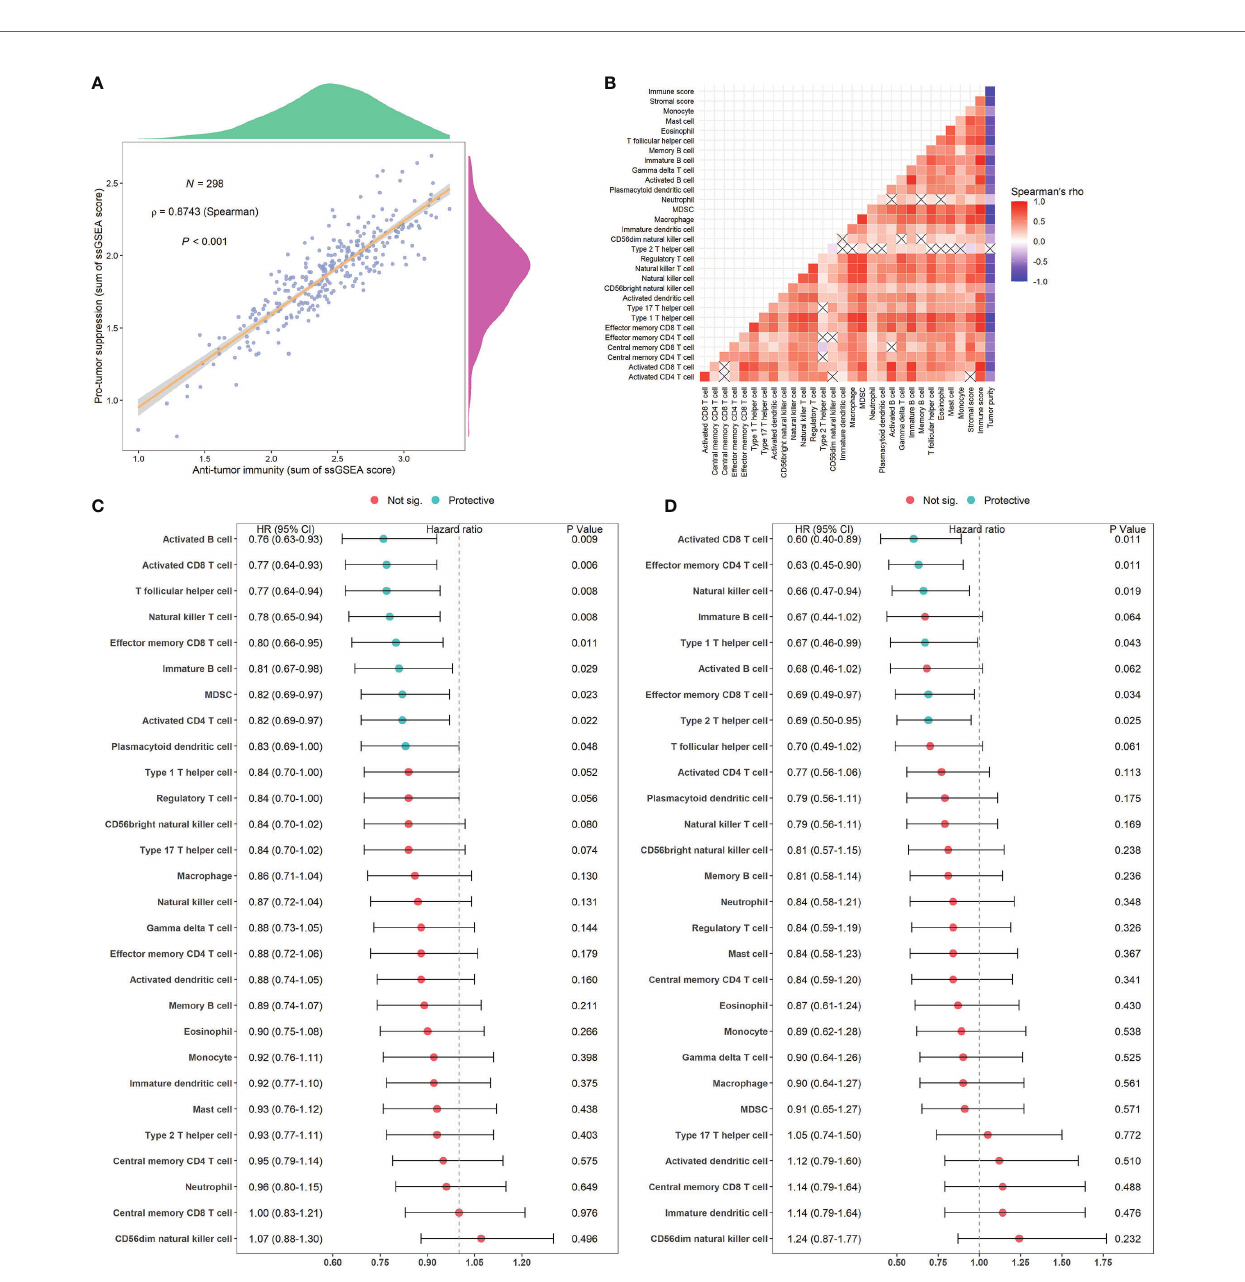
FIGURE 5 | Correlations of microenvironment cells and prognostic signi fi cance of them in TNBC. (A) Correlations between in fi ltration of cell types executing anti- tumor immunity (activated CD4 + T cells, activated CD8 + T cells, CD4 + Tcm cells, CD8 + Tcm cells, CD4 + Tem cells, CD8 + Tem cells, Th1 cells, Th17 cells, activated DCs, CD56bright NK cells, NK cells, NKT cells) and cell types executing pro-tumor, immune suppressive functions (Treg, Th2 cells, CD56dim NK cells, immature DCs, macrophages, MDSCs, neutrophils, and pDCs). The correlation coef fi cient ( r ) is generated by Spearman ’ s correlation. The shaded area represents 95% con fi dent interval. (B) Correlations of the relative abundance of tumor-in fi ltrating immune cells using Spearman analysis. The stromal score, immune score and tumor purity were also plotted. A negative correlation is marked with blue and a positive correlation with red. “ × ” means the corresponding correlation coef fi cient is regarded as insigni fi cant ( P > 0.05). (C, D) Estimation of the prognostic value of each cell subset by using a univariate Cox proportional hazards model for the METABRIC cohort (C) and the GSE58812 cohort (D)